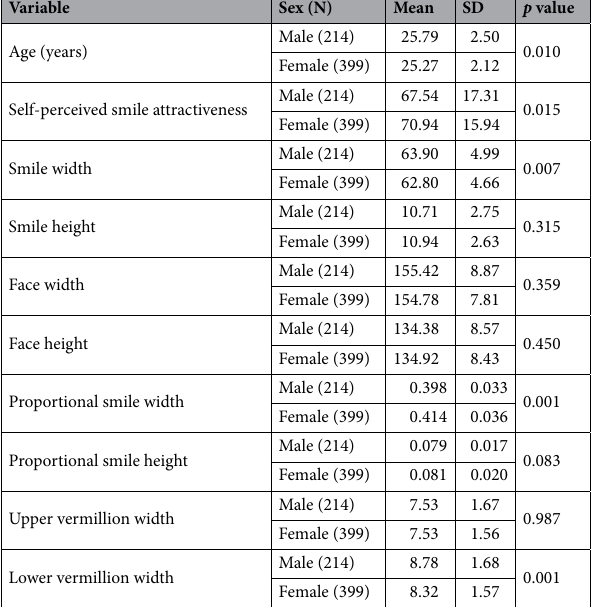
Table 2. Differences between males and females in age, self-perceived smile attractiveness scores and smile